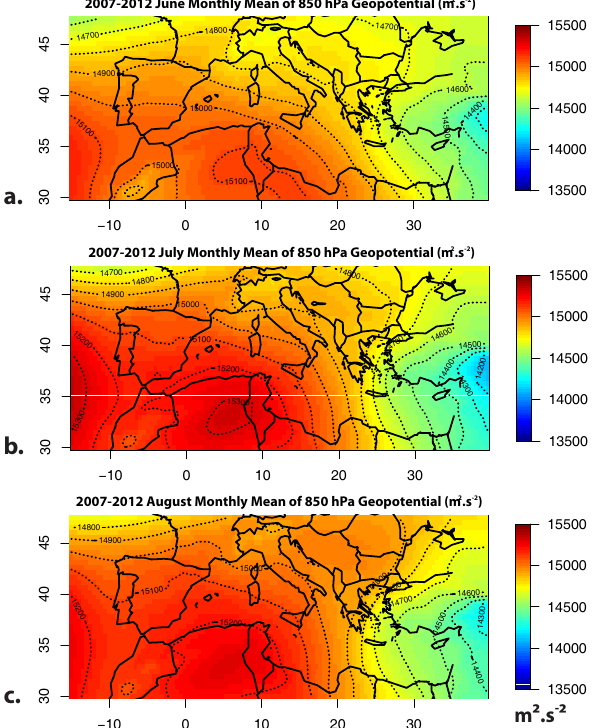
Figure 7. 2007–2012 monthly mean of 850hPa geopotential (m 2 s − 2 ) taken from 12h ERA-Interim reanalysis (colour shading and black contour lines) for (a) June, (b) July and (c) August.